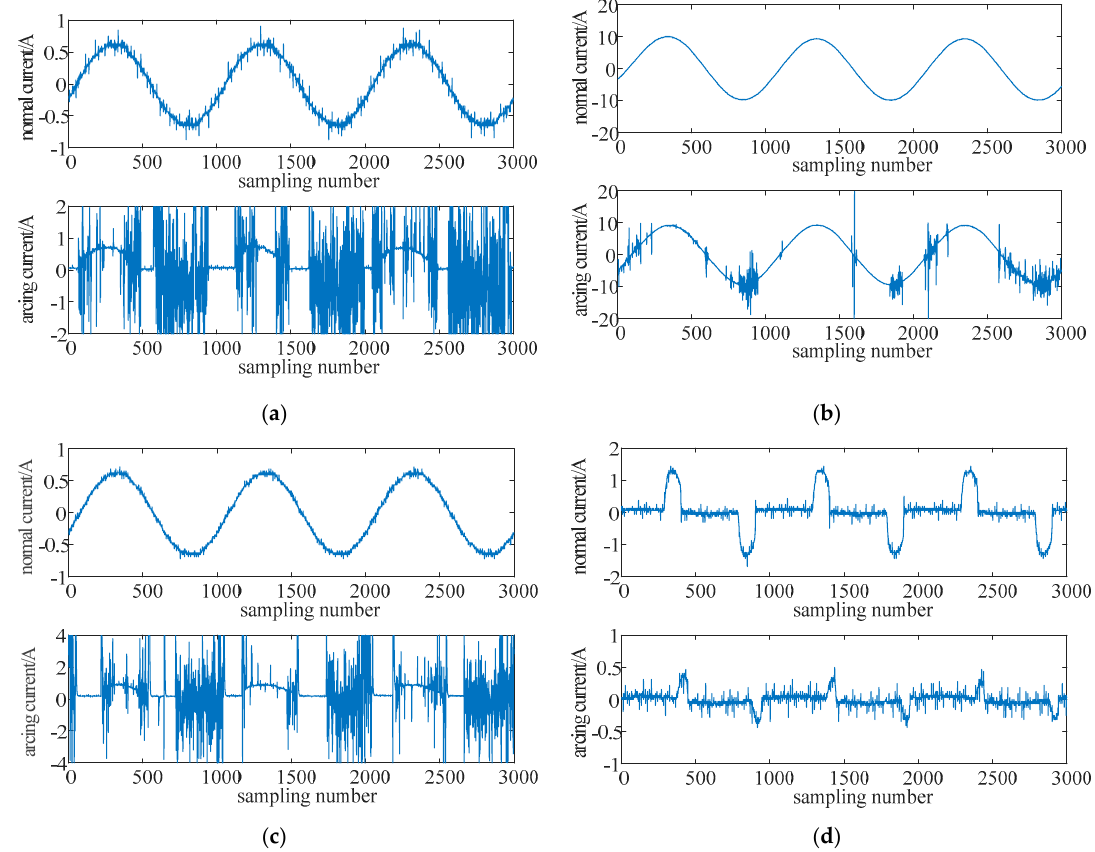
Figure 7. Normal current and arcing current waveforms of four kinds of loads: ( a ) resistive load; ( b ) inductive load; ( c ) resistive and inductive load; ( d ) nonlinear load.